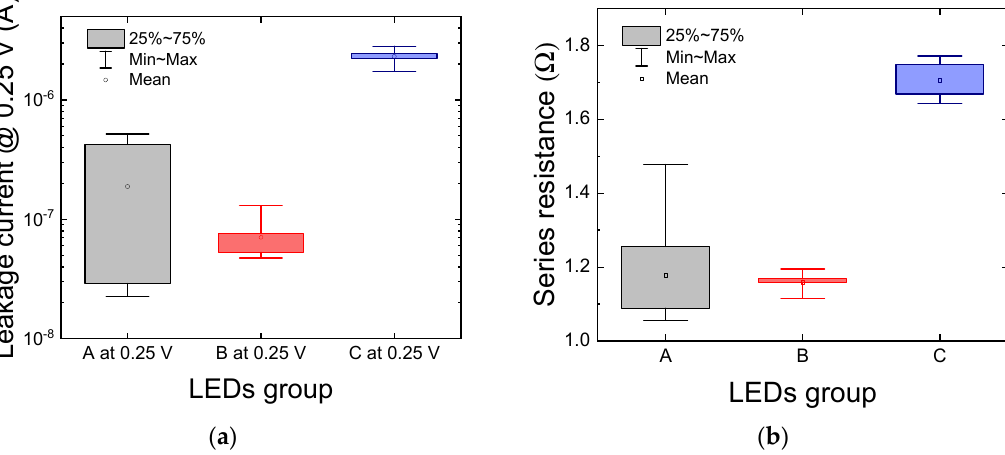
Figure 2. Statistical variation, among a population of 10 devices, of ( a ) the forward leakage current, measured at 0.25 V, and ( b ) of the series resistance of the samples. The box charts show the mean value, minimum and maximum values, and the data range between the 25th and the 75th percentiles. The measuring temperature is T AMB = 25 °C.